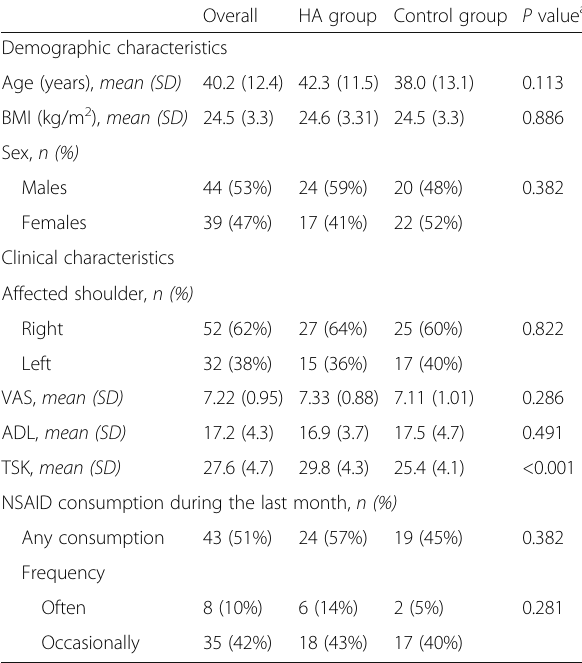
Table 1 Baseline characteristics of study patients (percentages of patients in categorical variables were calculated for each group) Overall HA group Control group P value